Question: Based on the figure, does the quantity rise or fall?
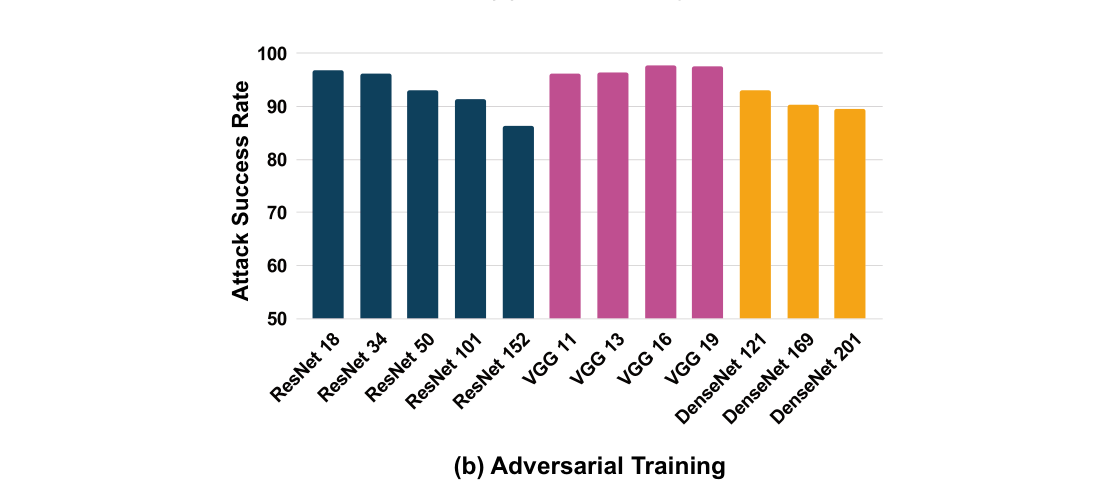
Answer: increasing